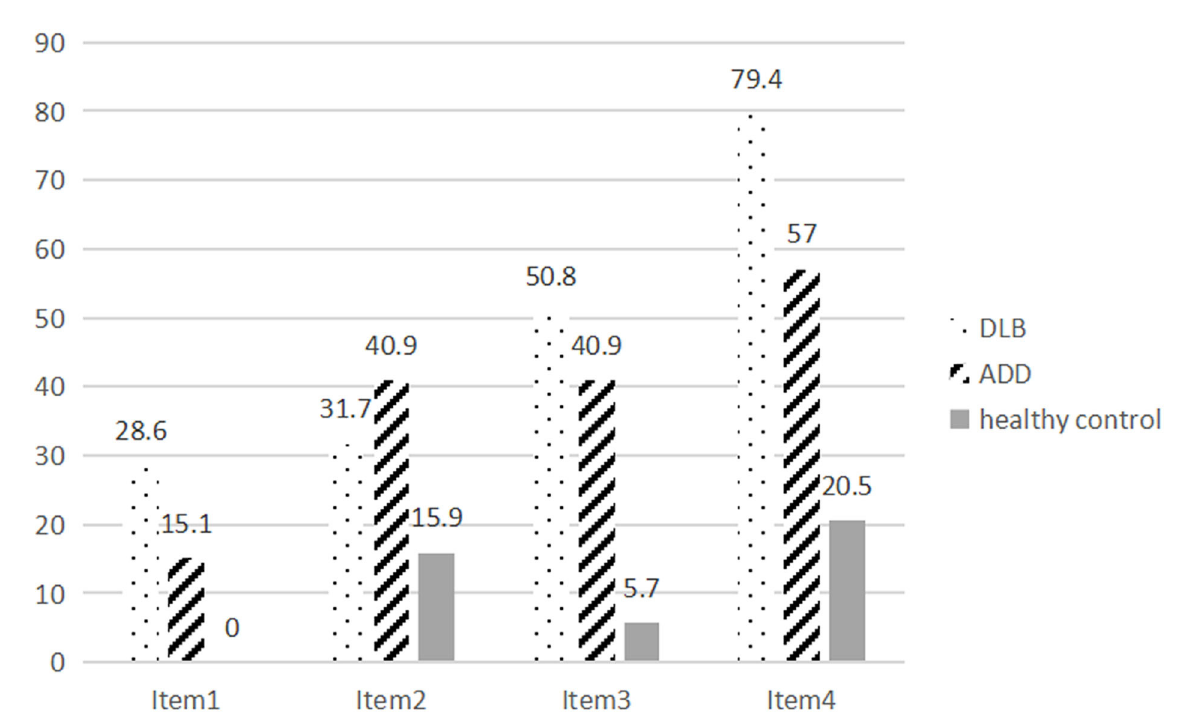
FIGURE1 The error rate of Items 1–4 of the gesture imitation test in patients with DLB and ADD and healthy controls.